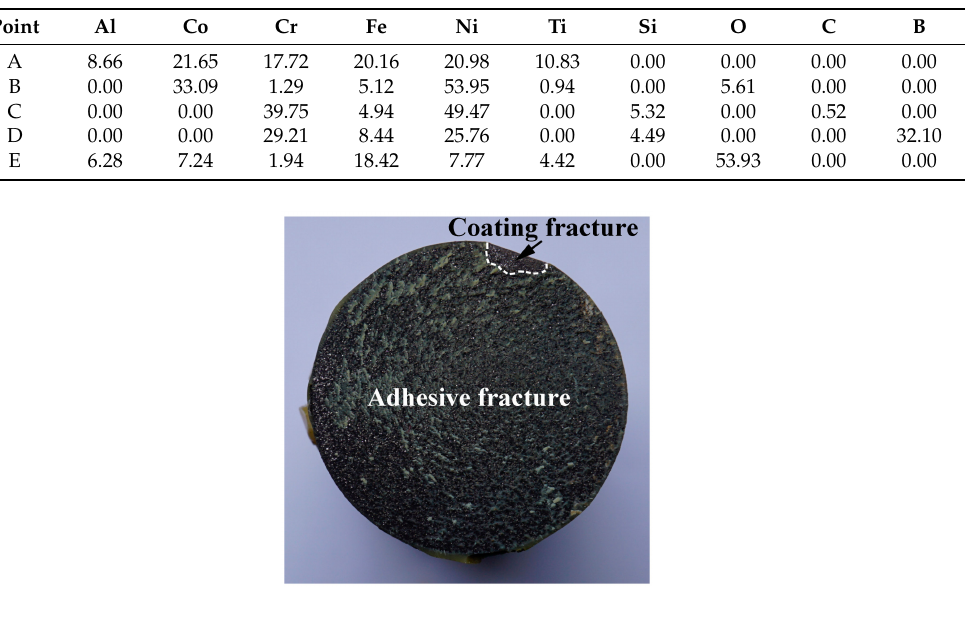
Figure 4. Cross-sectional microstructure of HEA/Ni60 coating ( a , b ) and coating/substrate interface ( c ). Table 2. Energy dispersive spectroscopy (EDS) analysis results of typical points in Figure 4b (at %).